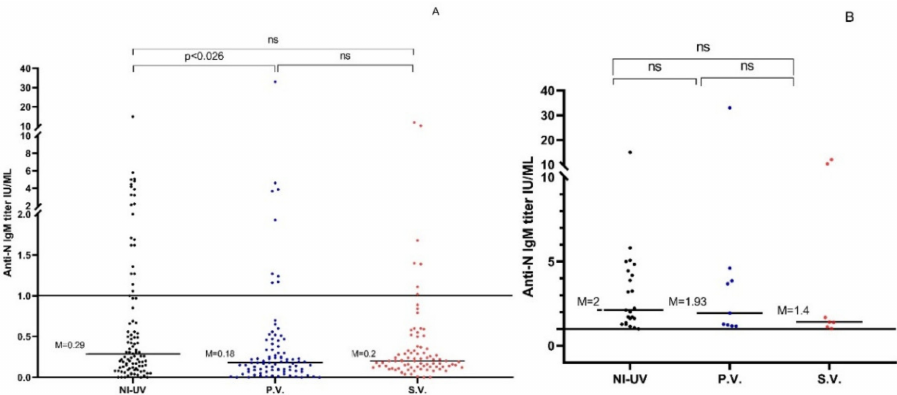
Figure 3. ( A ) Anti-N IgM titers in the 3 studied groups for all participants. ( B ): Anti-N IgM titers in the 3 studied groups after excluding seronegative samples. NI-UV: Naturally Infected Unvaccinated, P.V.: Pfizer Vaccinated, S.V.: Sinopharm Vaccinated, M: Median, ns: Nonsignificant ( p > 0.05).